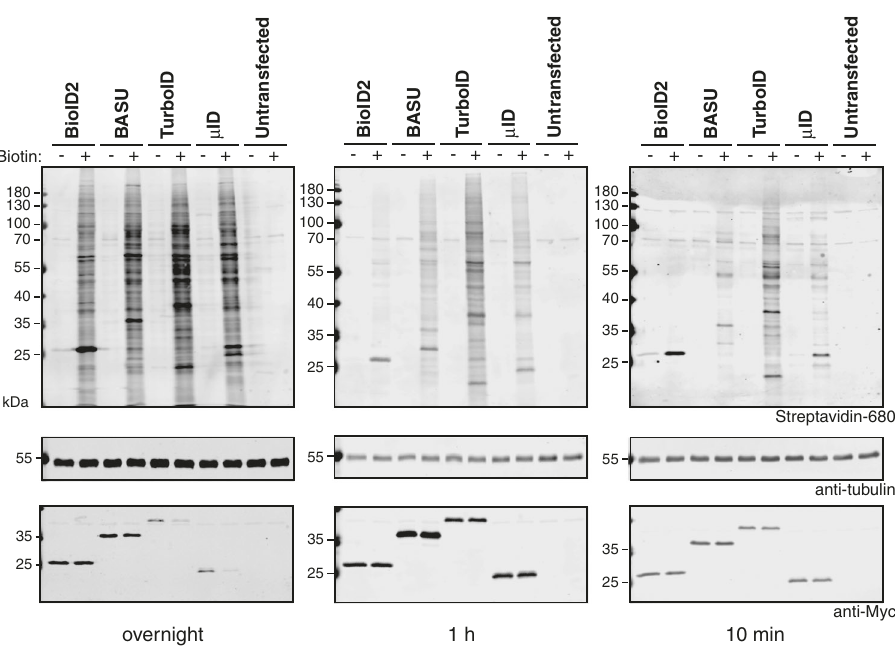
Fig. 2 microID shows ef fi cient biotinylation at short labeling times. Blots of lysates of HeLa cells transiently transfected with the indicated constructs and incubated with 50 μ M biotin overnight (left), for 1 h (middle), or for 10 min (right). Biotinylation was analyzed using IRDye680-labeled streptavidin and expression levels of the fusion proteins with antibodies against the Myc tag as